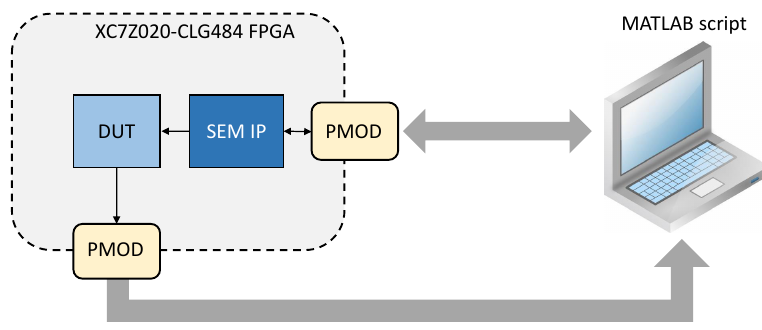
Figure 6. Experimental set-up used to test the reliability of the IP